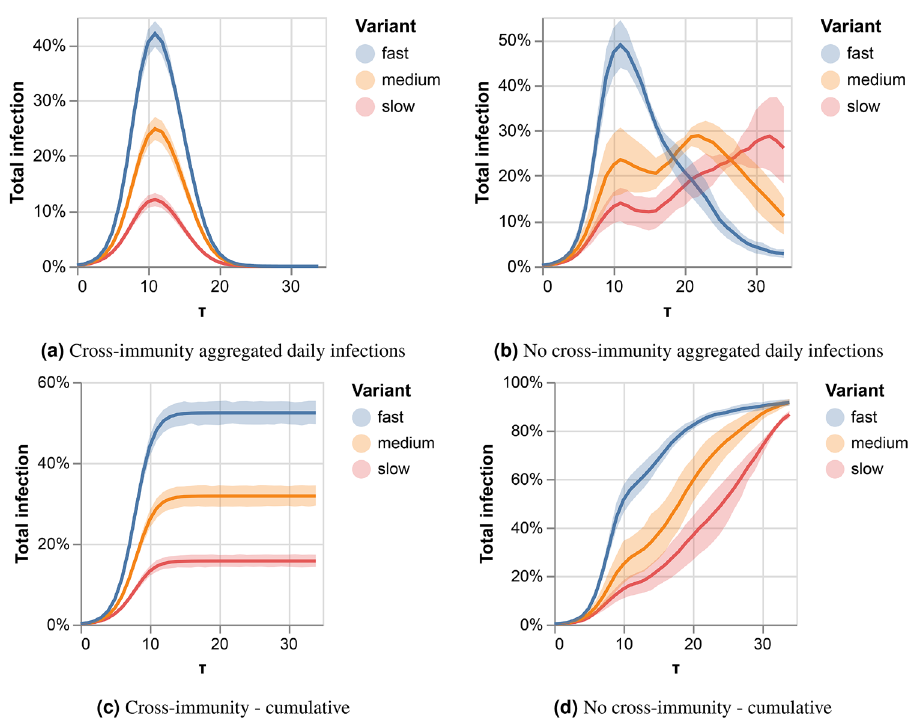
Figure 5. Three competing variants over temporal random network. Left panels correspond to full cross- immunity conditions, right panels to no